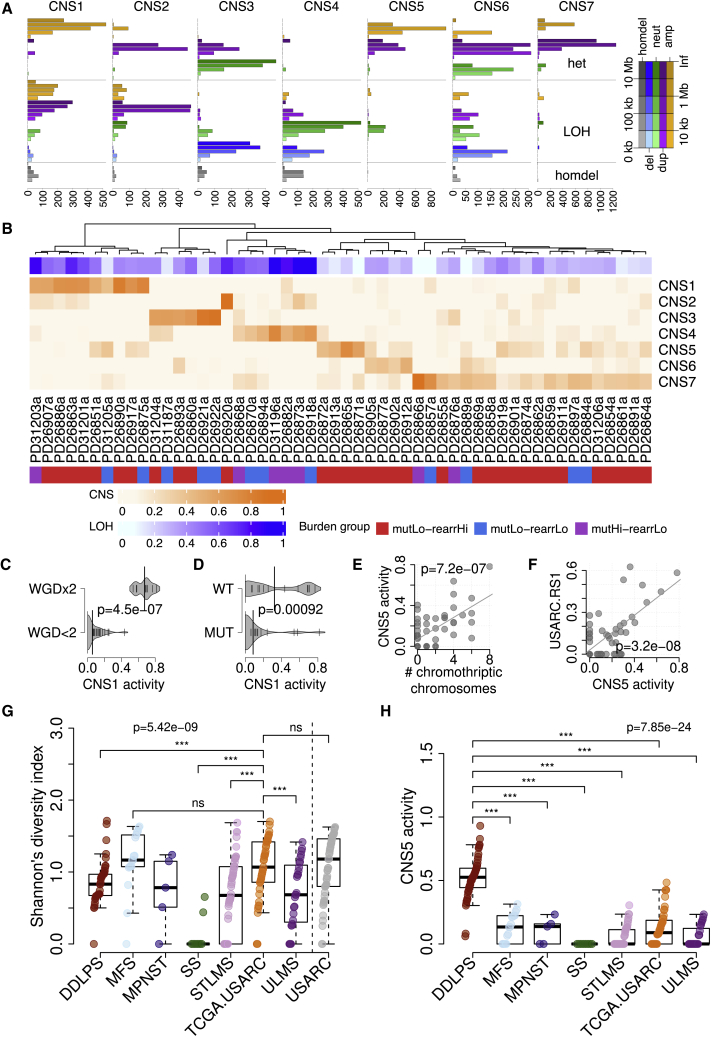
Copy-Number Signatures(A) Seven copy-number signatures identified using NMF; amp, amplified (CN ≥ 1, orange); dup, duplicated (3 ≤ CN ≤ 4, purple); neut, neutral (CN, 2, green); del, deletion (CN ≤ 1, blue); homdel, homozygous deletion (CN, 0, gray); het, heterozygous. x axis, strength of each copy-number class in each signature.(B) Activities of copy-number signatures (CNS) per sample, with associated proportion of the genome that shows LOH, and molecular classification groups.(C) Density plot of CNS1 activity stratified by whether the sample has one or fewer genome doubling events (WGD<2) or has two genome doubling events (WGD×2). Thickness of gray region indicates density. Small vertical lines, data points. Large vertical lines, median.(D) Density plot of CNS1 activity stratified by TP53 mutation status.(E) Scatterplot of CNS5 activity against number of chromothriptic chromosomes. Gray line indicates linear fit.(F) Scatterplot of CNS5 activity against USARC.RS1 activity. Gray line indicates linear fit.(G) Diversity estimates of CNS in TCGA sarcoma subtypes and our USARC cohort.(H) CNS5 activity stratified by tumor type in TCGA.Boxes show lower quartile, median, and upper quartile; lines denote furthest point within 1.5× the interquartile range away from the box. See also Figures S5 and S6 and Table S5.